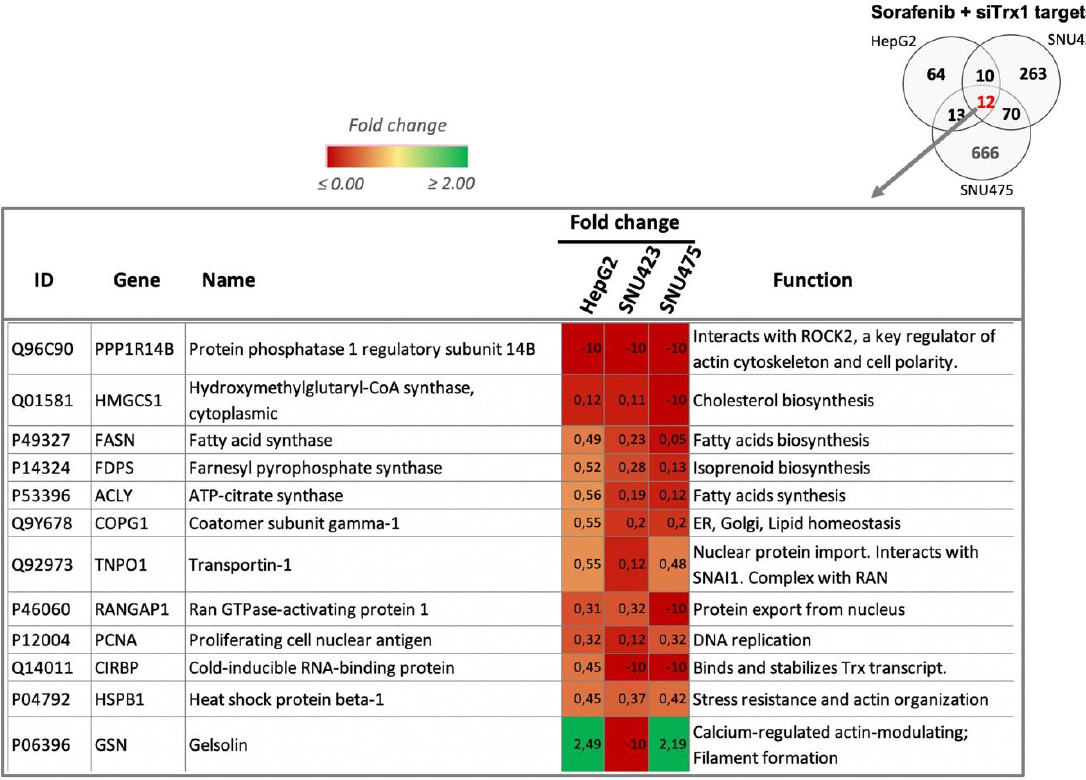
Figure 5. Common target proteins of the Sorafenib + siRNATrx1 treatment. Twelve proteins that changed significantly in HepG2, SNU423, and SNU475 cells are shown. A brief description of their function was extracted from UniProt; fold changes relative to their respective controls treated with solvent + Non-target siRNA are indicated in a color scale. Quantitative proteomic analysis as described in Materials and Methods ( N = 3). Tenfold-change values correspond to proteins that were present in the controls but were not detected in the treated samples.